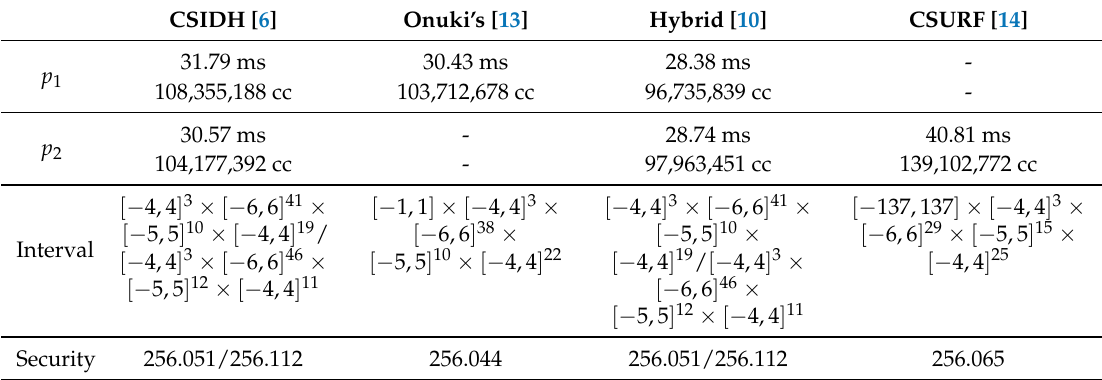
Table 5. Wall-clock time, clock cycles, and security considering collisions with modifying